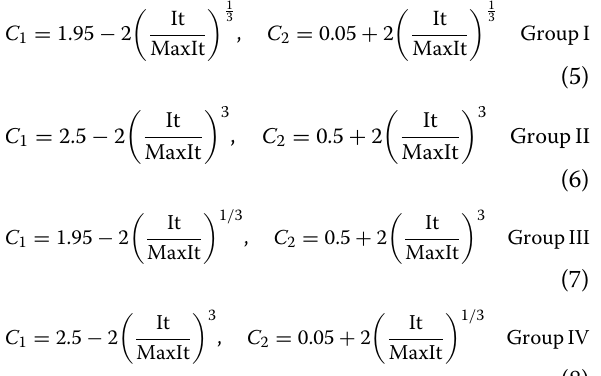
ticles swarm optimization (AGPSO), dwarf mongoose optimization algorithm (DMOA), and weighted mean of vectors (INFO), are used to compare and verify the performance of PSCO. The AGPSO is a variant of PSO developed by Mirjalili et al. (2014). The AGPSO assumes that the individuals of the population are not similar. The population is divided into four groups. The individual learning and global learning coefficients, C 1 and C 2 , are